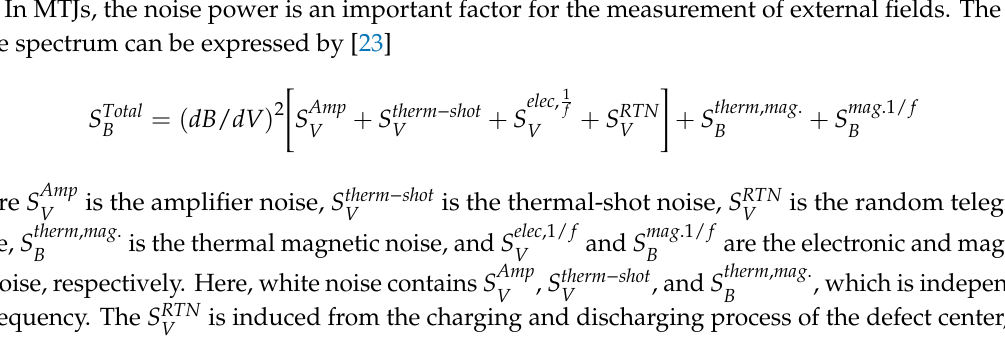
Figure 4. Dependence of ( a ) the linear range of the resistance response and ( b ) sensitivity on the aspect ratio of the free layer that ranged from 1 to 4 at a bias voltage of 100 mV and zero magnetic field. Here, the linear range shows a nonlinearity of 10% FS for each sensor.